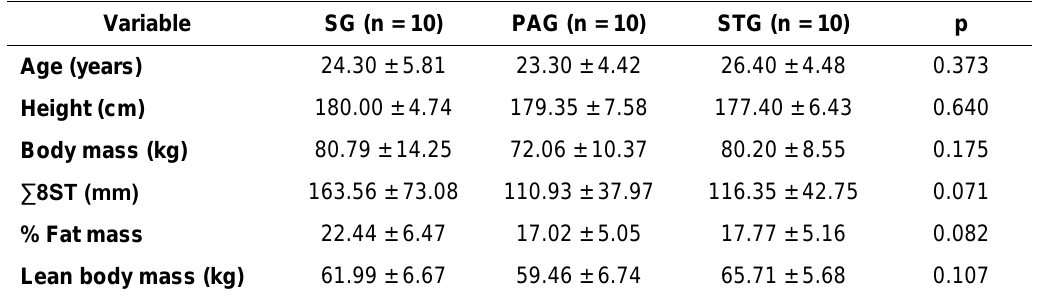
Table 1. Physical characteristics of sedentary (SG), physical active (PAG) and strength-trained (STG)